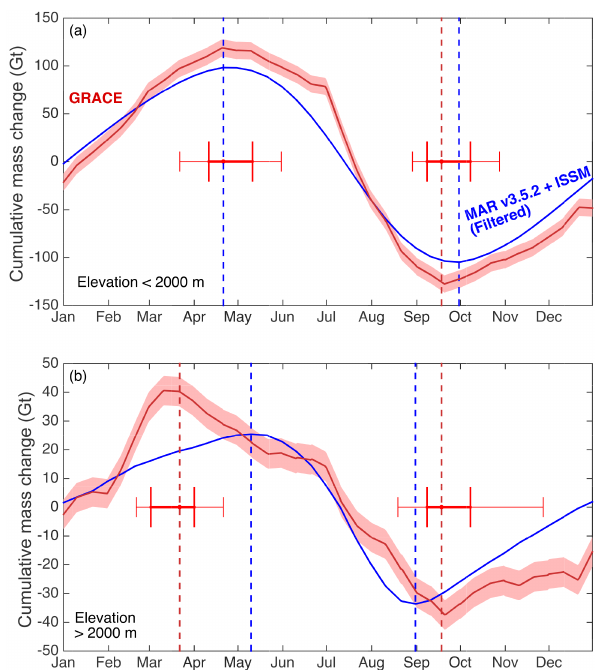
Figure 12. Same as Fig. 8b, but for (a) regions below 2000m in elevation, and (b) above 2000m in